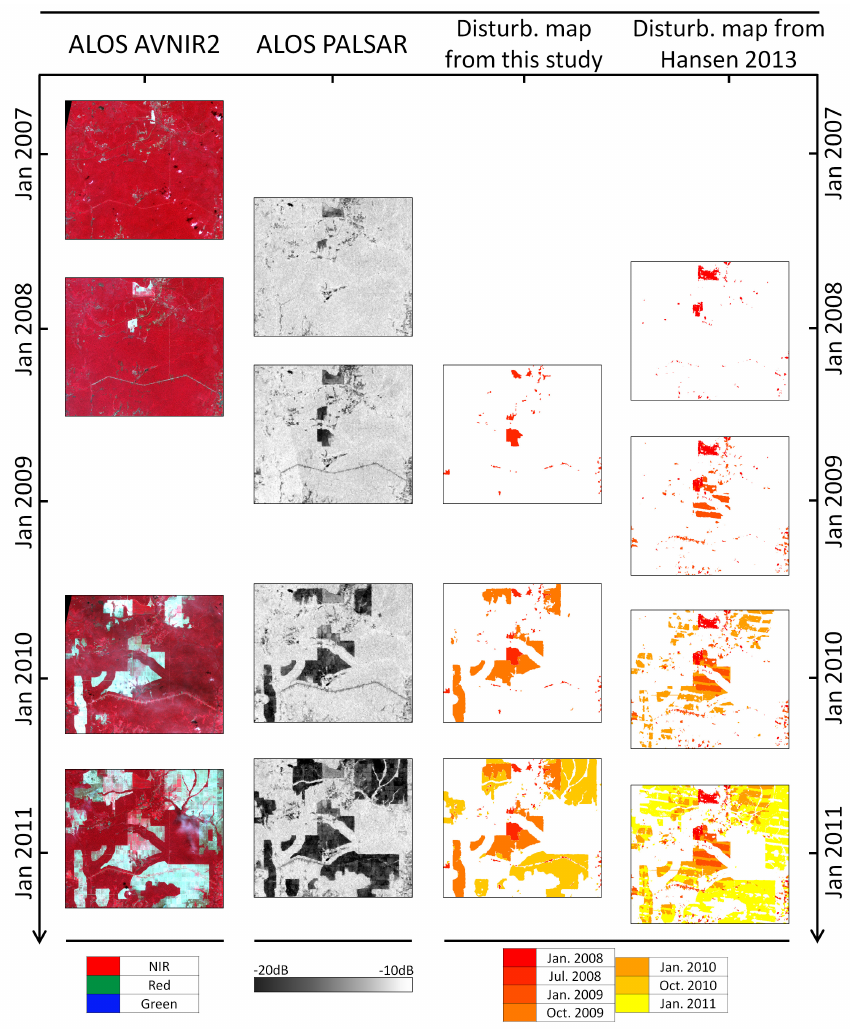
Figure 9. Visual comparison of the temporal series of AVNIR-2 data used to derive the training and testing database (Section 2.3), PALSAR data, our PALSAR-derived forest disturbances and regrowth map and the Landsat-based disturbances map from [9]. The 17 × 15 km scene is centered at ∼ 12.56 ◦ N–105.46 ◦ E. This example highlights the effect of the Landsat 7 defective scan line corrector, which decreased Hansen’s map